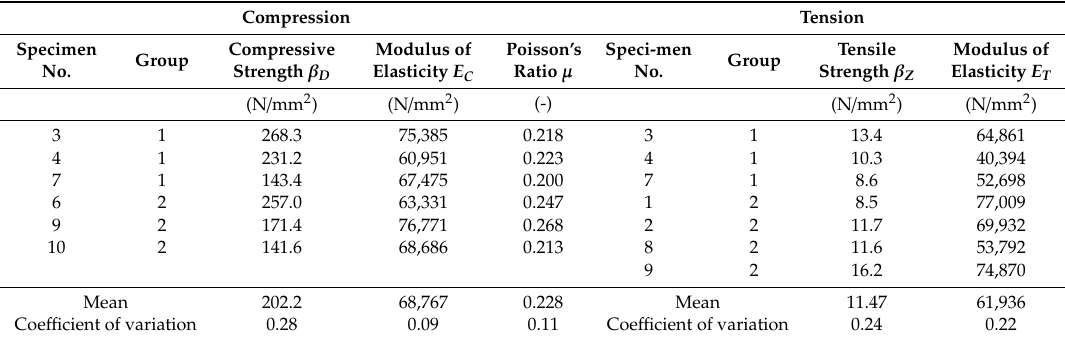
Table A1. Static modulus of elasticity of revetment stones under compression and tension as well as compressive strength, Poisson’s ratio and tensile strength (after [31]). Compression Tension Specimen